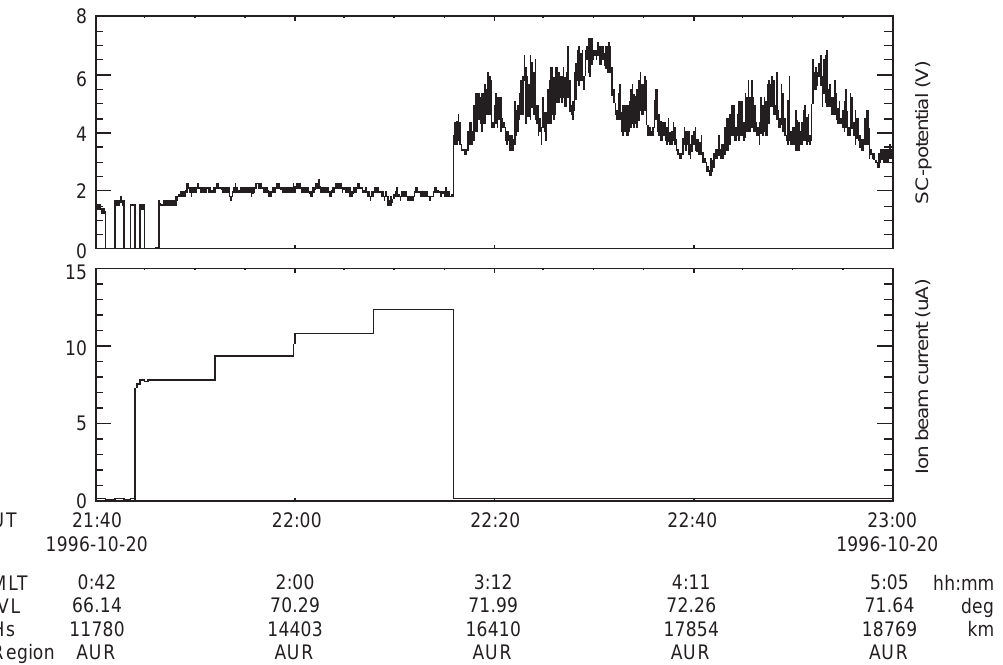
Fig. 5. E(cid:128)ect of active ion beam emission on the spacecraft potential, measured on 20 October, 1996, at 21:40–23:00 UT; upper panel : spacecraft potential data received from the instrument IESP–2M via the on-board inter-experiment link; lower panel : ion beam